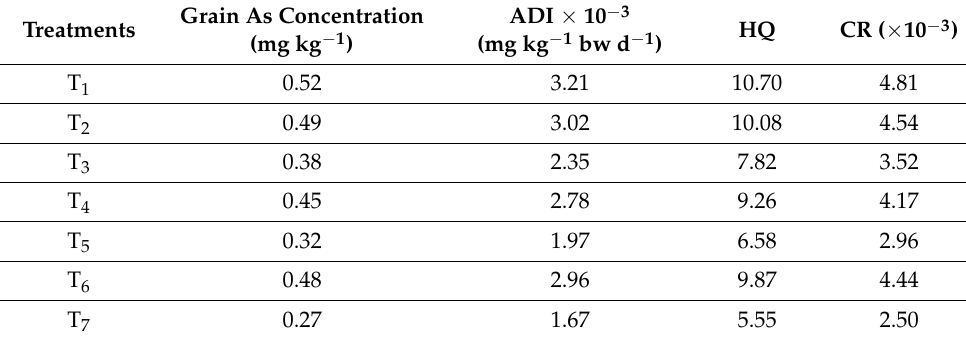
Table 5. Average daily intake from inorganic As and health risk assessment.